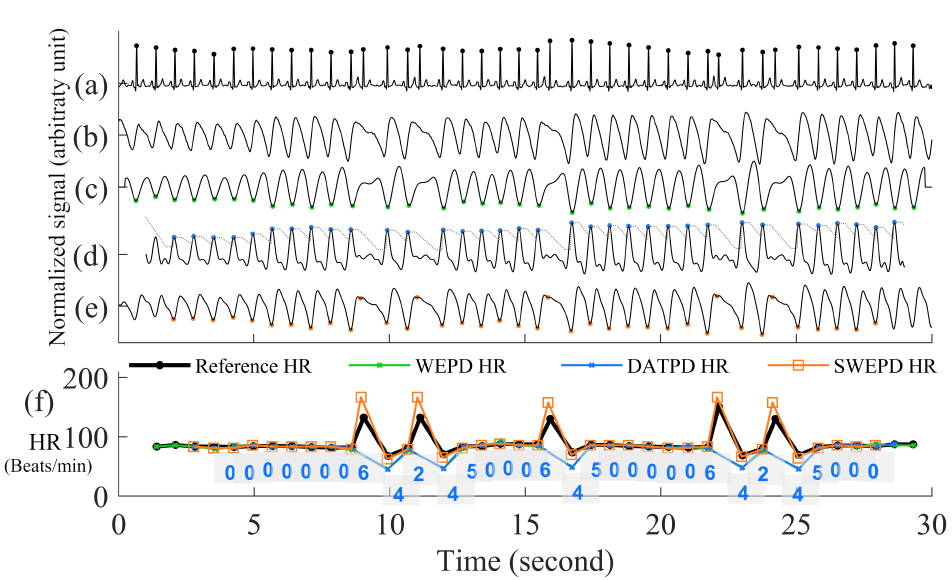
Figure 7. Representative example of the peak correction for fast heart rate PVC. Top panel ( a ) is reference ECG; panel ( b ) is the raw PPG signal; panel ( c ) is the peak detection output from WEPD; panel ( d ) is peak detection from DATPD; panel ( e ) is the peak correction for PAC/PVC with corrected heartbeats (unit: BPM) via SWEPD. The bottom panel ( f ) is heart rate comparison with the reference heart rate, estimated heart rates from WEPD, DATPD, and heart rates from the peak correction of PAC/PVC. Region information for each heartbeat of DATPD peak detection is labeled on the heart rate in bottom panel ( e